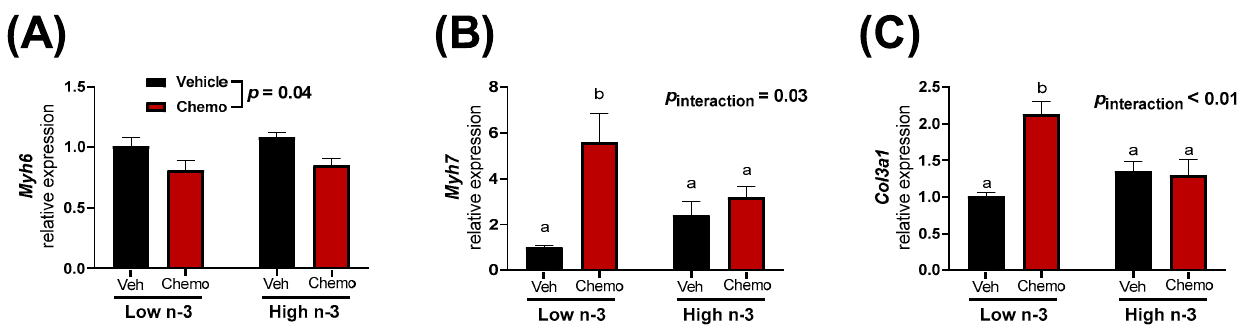
Figure 2. Heart gene expression of ( A ) Myh6 , ( B ) Myh7 , and ( C ) Col3a1 . Data presented as group means ± SEM ( n = 5/group). A two-way ANOVA with a diet x chemo interaction was used to detect the differences between factors. Pairwise comparisons for variables with significant inter- actions were performed using a Tukey’s post hoc test. Variables with different annotations were different at p < 0.05. Veh—saline vehicle injections; Chemo—9 mg/kg anthracycline + 90 mg/kg cyclophosphamide injections; Low n-3—0 g/kg EPA + DHA diet; High n-3—12.2 g/kg EPA + DHA diet (~2%